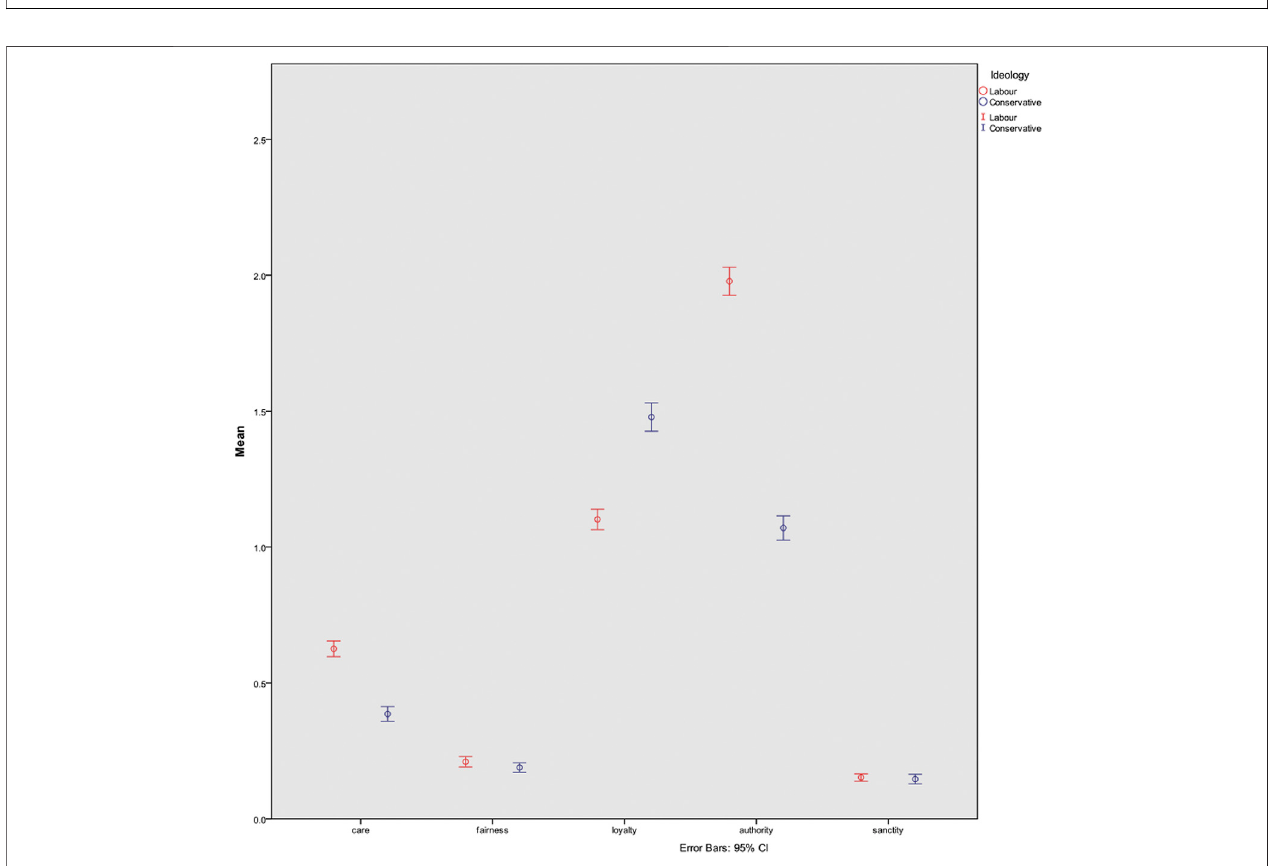
FIGURE 6 | Mean differences with error bars for moral intensity per foundation between Labor and Conservatives. There are signi fi cant differences in the use of Care, Loyalty and Authority.